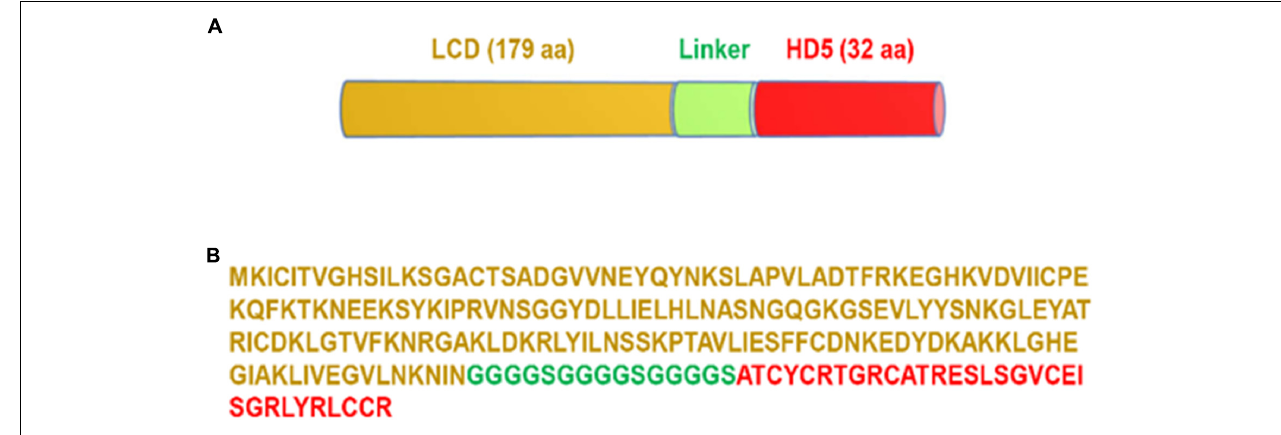
FIGURE 1 | Design of LHD fusion protein. (A) Diagram of LHD containing catalytic domain of the lysin from phage phiC2 (LCD), a linker (GGGGS) 3 , and human alpha-defensin protein